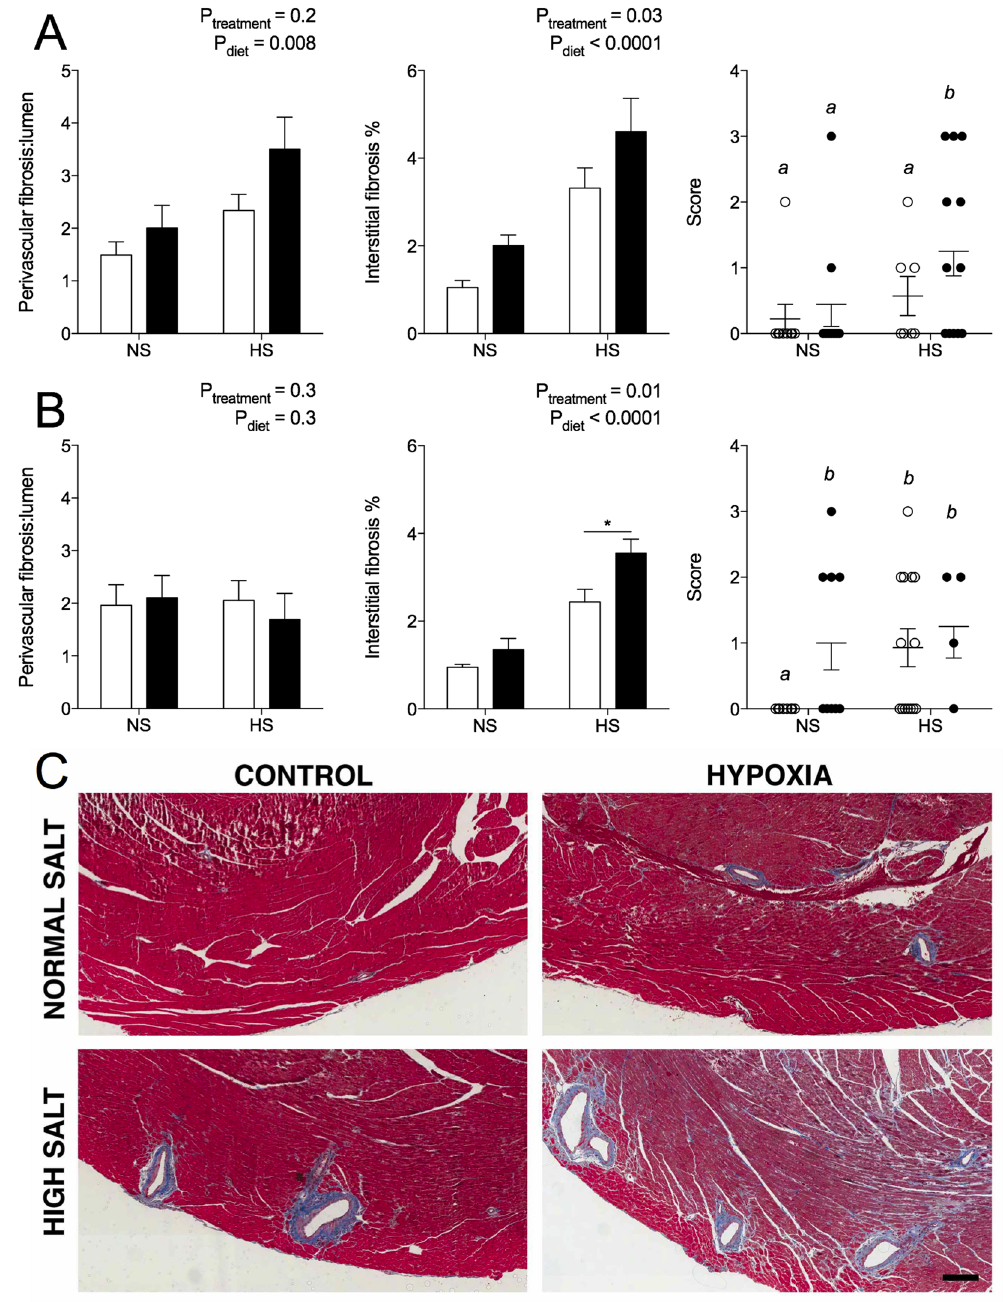
Figure 3. Cardiac histopathology of offspring at 12 months of age. Perivascular fibrosis area normalised to lumen area, interstitial fibrosis expressed as percentage of cardiac tissue, and histology score in male ( A ) and female ( B ) offspring. ( C ) Masson’s Trichrome staining of cardiac tissue in males. Blue staining marks collagen (fibrosis). Scale bar represents 200 µ m. Scoring analysed via one-way ANOVA with letters denoting statistical differences between groups. Perivascular and interstitial fibrosis analysed via two-way ANOVA. * P < 0.01 by Sidak post hoc . Values are mean ± SEM. Male: N = 5–11/group; female: N = 4–8/group. Control: open bars/ points; hypoxia: closed